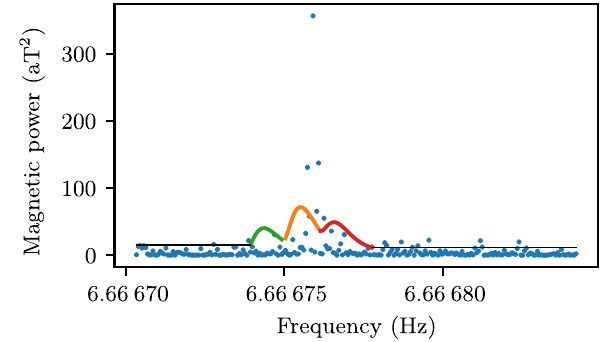
FIG. 9. Experimental magnetic power near 6.666 Hz (dots). The average magnetic power of a signal candidate identified by the likelihood analysis at 6.666 75 Hz is shown by the solid line. For the purposes of testing an axion candidate directly against the signal model (rather than against a white-noise null hypothesis as in our likelihood analysis), we split the signal power into three regions identified by colored lines to calculate the power under each peak. These peaks are due to sideband modulations of the axion ’ s power due to Earth ’ s rotation about its axis [see discussion around Eq. (8)]. The selection of these three regions is driven by a need to discriminate between true and false axion signals (see discussion in Sec. V of the text and Fig. 10).